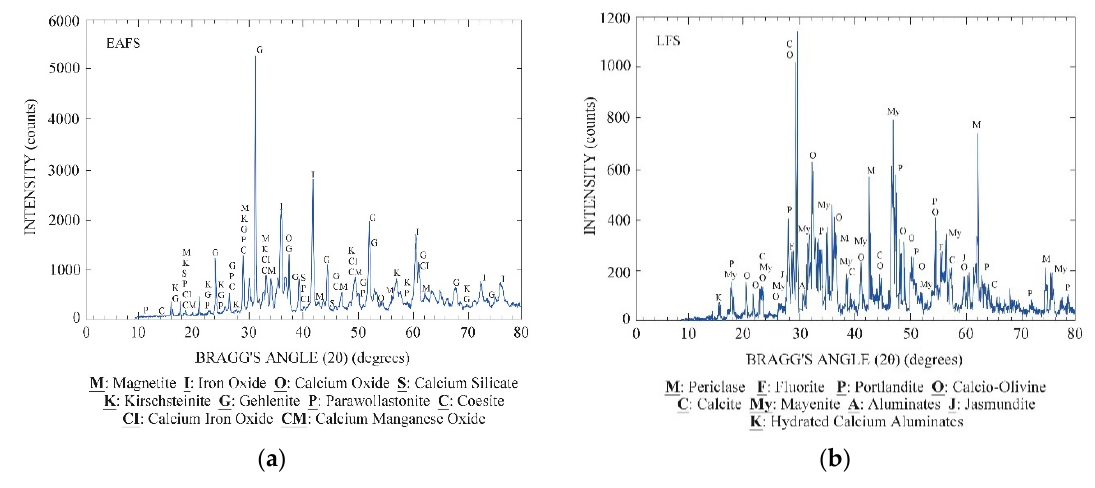
Figure 3. ( a ) EAFS diffractogram; ( b ) LFS diffractogram.